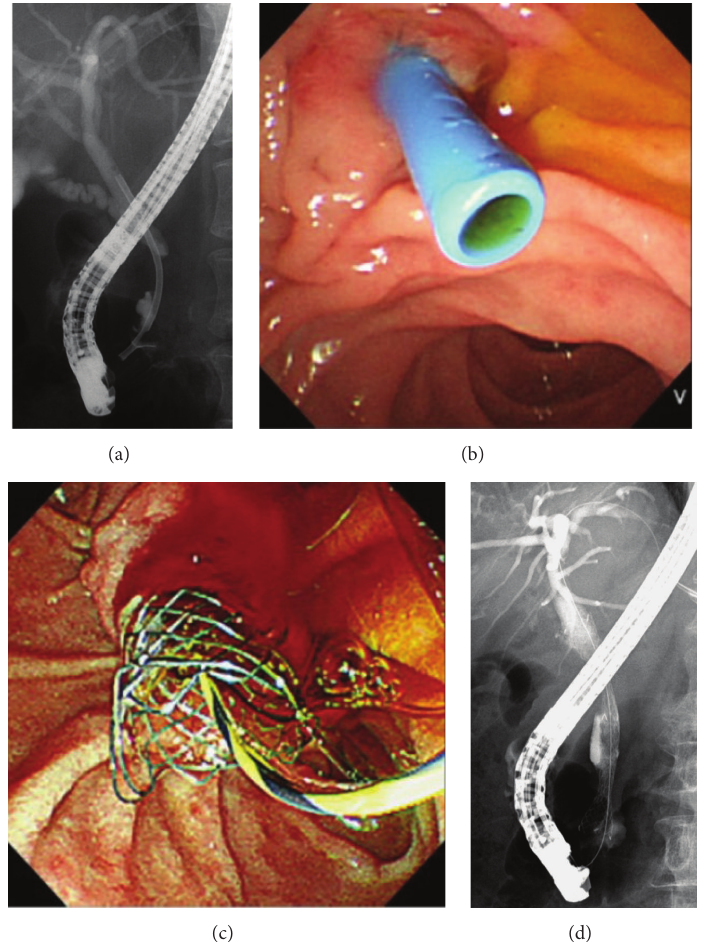
Figure 1: Endoscopic biliary drainage. (a), (b) X-ray image and endoscopic image of plastic stent. (c), (d) X-ray image and endoscopic image of metallic stent.